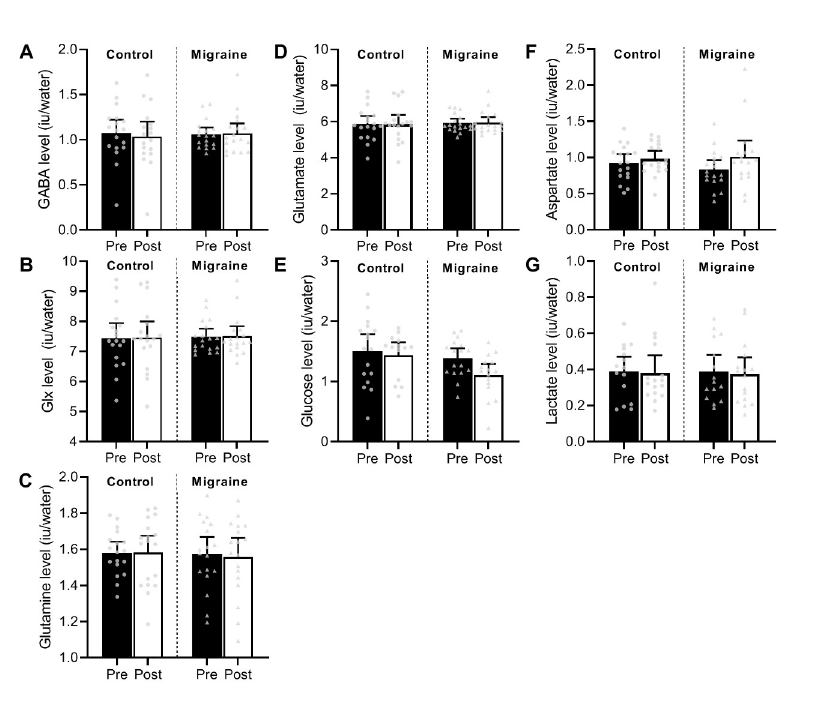
Fig 2. Group averaged metabolite levels referenced to water. Group averaged metabolite levels (referenced to water) for (A) GABA, (B) Glx, (C) Glutamine (Gln), (D) Glutamate (Glu), (E) Glucose (Glc), (F) Aspartate (Asp) and (G) Lactate (Lac) pre- and post-checkerboard. Group averaged data and individual data are shown here (pre- checkerboard: dark bars, controls: circles; post-checkerboard: light bars, migraine: triangles) with error bars as 95% confidence intervals of the mean.